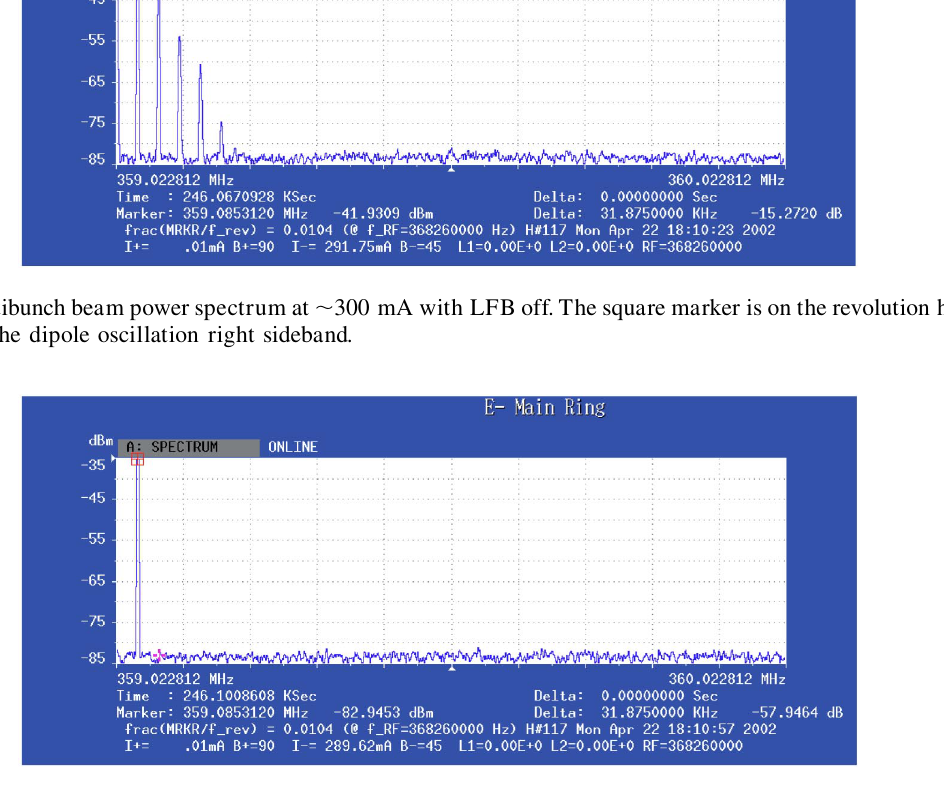
FIG. 8. (Color) Multibunch beam power spectrum at (cid:2) 300 mA with LFB on. The square marker is on the revolution